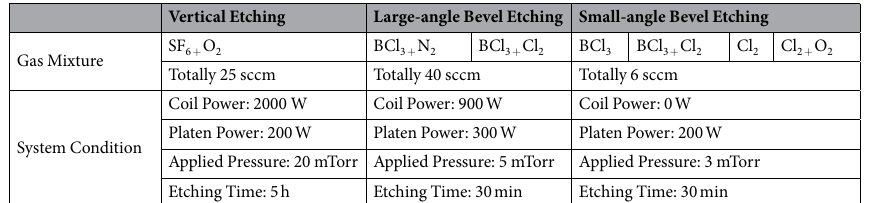
Table 1. Summarization of the detailed information of all experiments conducted in this work. All of the experiment is based on 4H-SiC substrate, Ni mask is applied in the process of vertical etching and large-angle bevel etching, and AZ4620 photoresist is used as the etching mask for small-angle bevel etching.